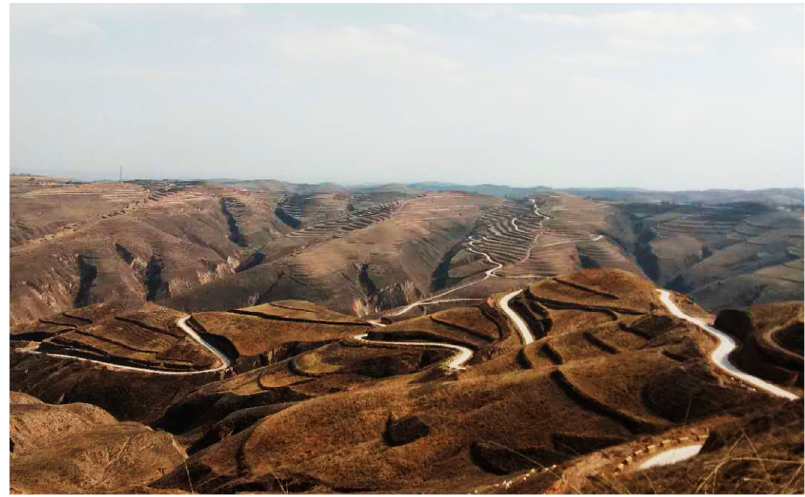
Figure 9. High circuity of the road network in Huining (photo by